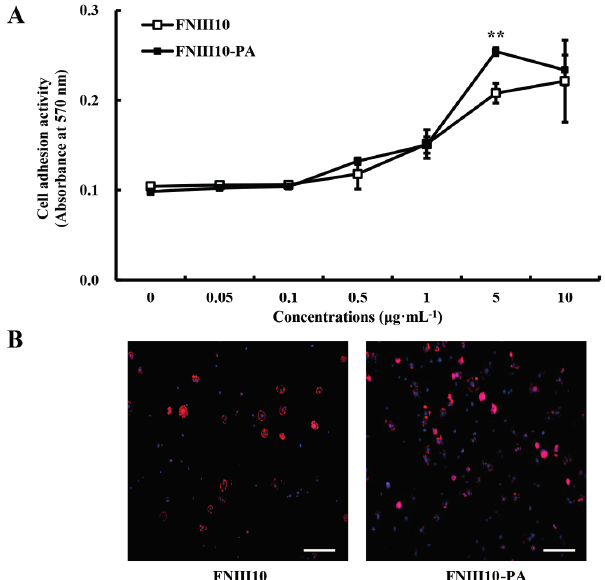
Figure 3. Cell adhesion activities of FNIII10-PA on rMSCs. Twenty-four well plates were coated with various concentrations of FNIII10 or FNIII10-PA overnight at 4 °C. Cells were seeded at a density of 1 × 10 5 cells/well on plates and incubated for 1 h at 37 °C. ( A ) Cell adhesion activities were measured by crystal violate assay and expressed as mean ± SD ( n = 3). ** p < 0.005; ( B ) CLSM images (nuclei in blue and F-actin in red). Scale bar, 50 μ